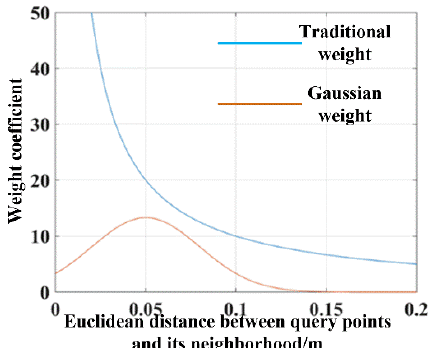
Figure 5. Weight variation trend of neighborhood points of a key point.